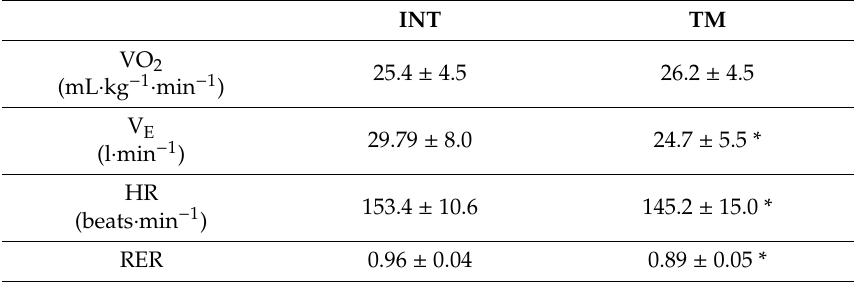
Table 3. Mean cardiometabolic responses during the entire 12 min integrative neuromuscular training (INT) and treadmill (TM)